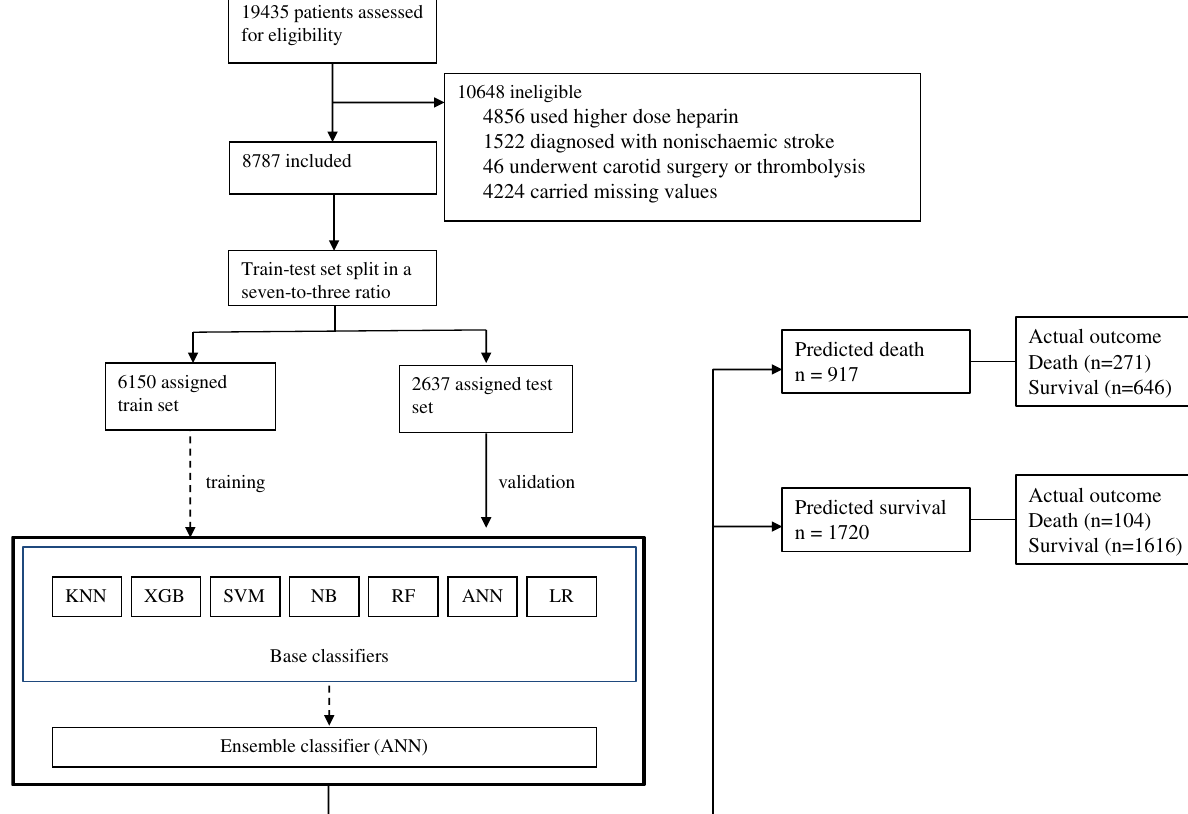
Figure 2. Flow of study patients. The confusion matrix of the final stacking ensemble learning produced the predicted number. The put-aside validation set evaluated the models after complete training.